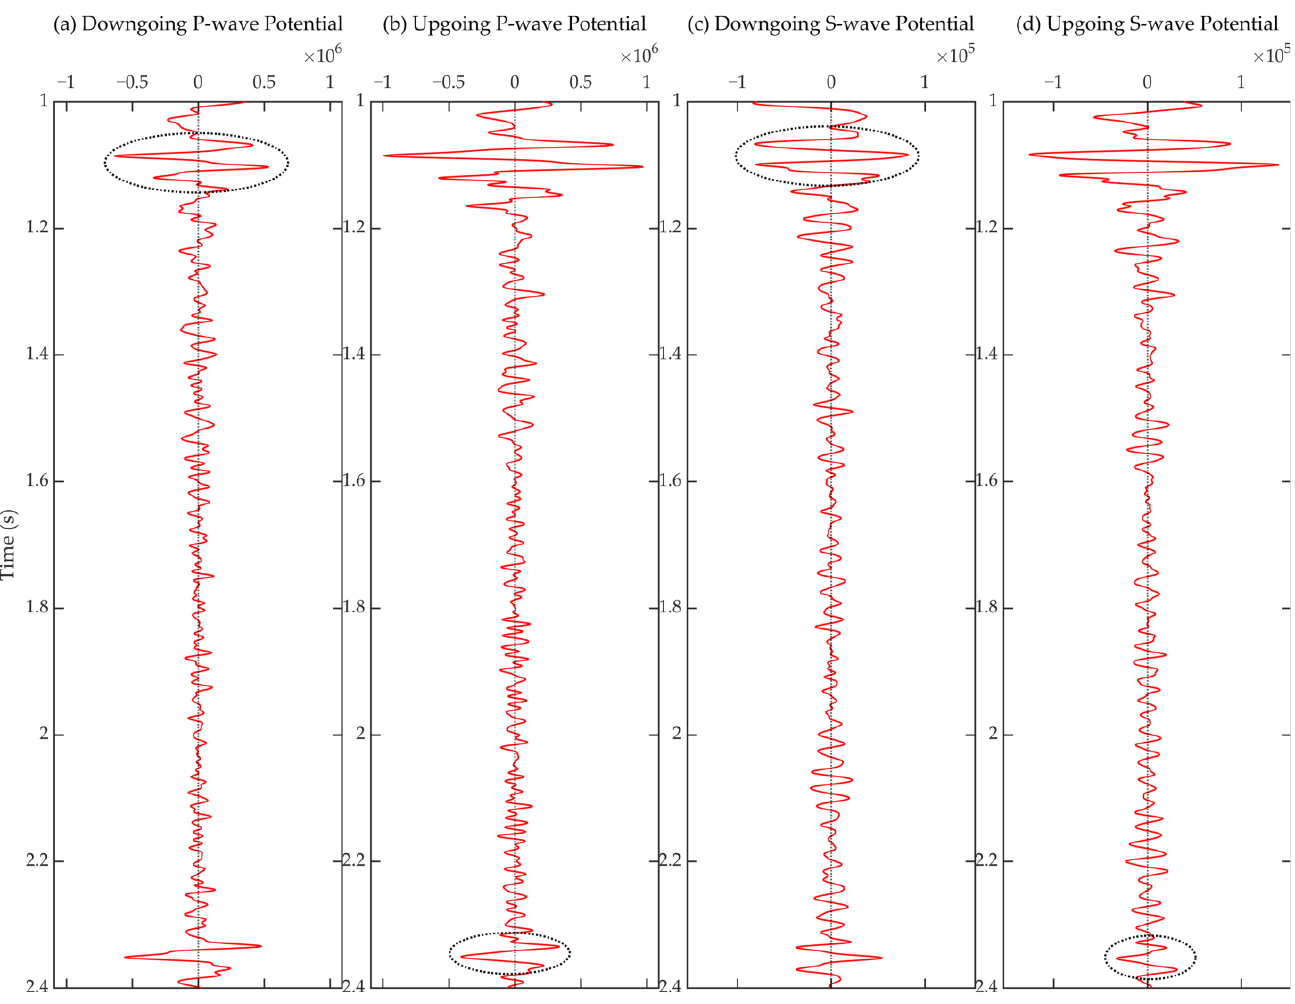
Figure 20. One-trace samples (the 300th trace, about 612.5 m in offsets) from the ( a ) downgoing P-potential, ( b ) upgoing P-potential, ( c ) downgoing S-potential, and ( d ) upgoing S-potential decom- posed just below the seafloor using the classical method with errored vertical velocity data. The degradations in the results are indicated by black dotted ellipses.